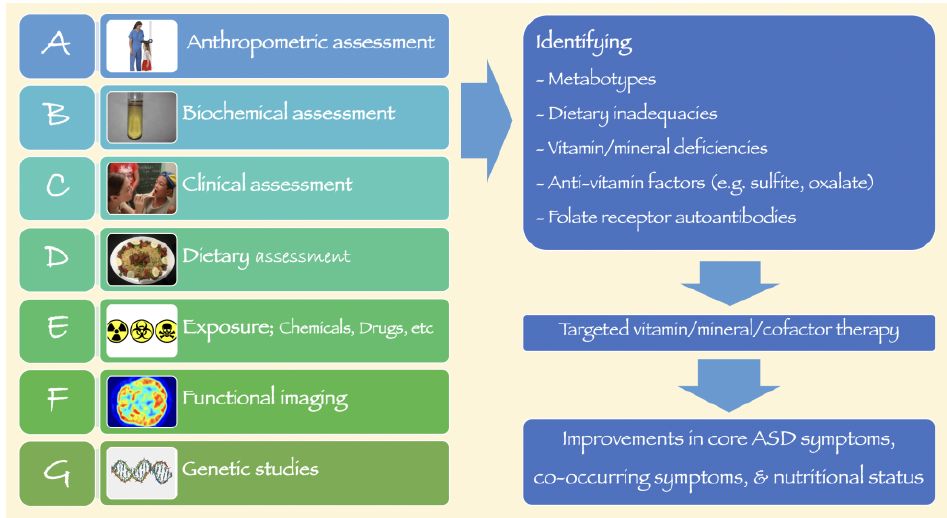
Figure 1. The multimodal and integrated approach (A to G approach) to determine the best vita- min/mineral/cofactor therapy in autism spectrum disorder (ASD).